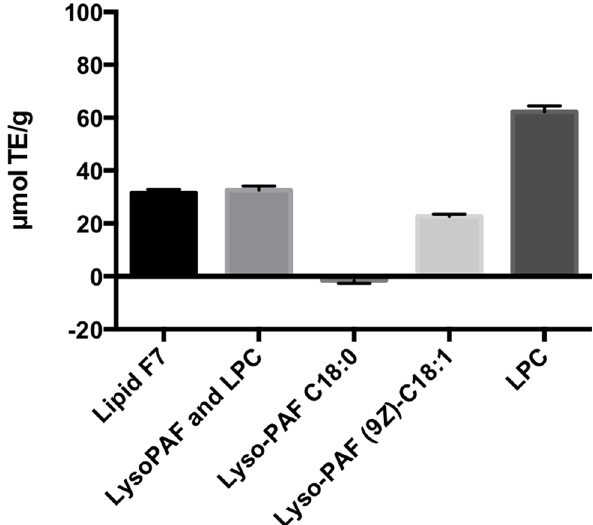
Fig 6. ORAC assay. Antioxidant capacities of the F7 lipid fraction and a lipid mixture containing Lyso-PAF C18:0 (44%), Lyso-PAF (9 Z )-C18:1 (44%), and LPC C18:0 (12%). Lyso-PAF C18:0, Lyso-PAF (9 Z )-C18:1, and LPC are expressed in μ mol Trolox equivalents (TE)/g, calculated from a Trolox standard